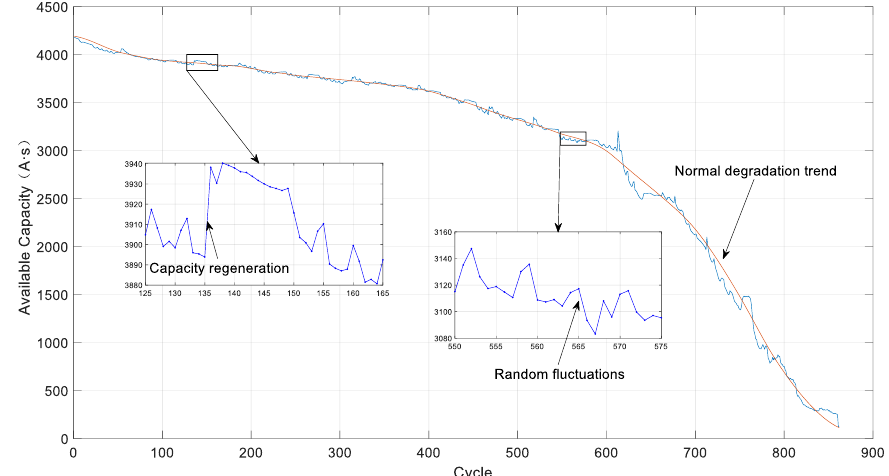
Figure 1. Lithium-ion battery degradation process curve.